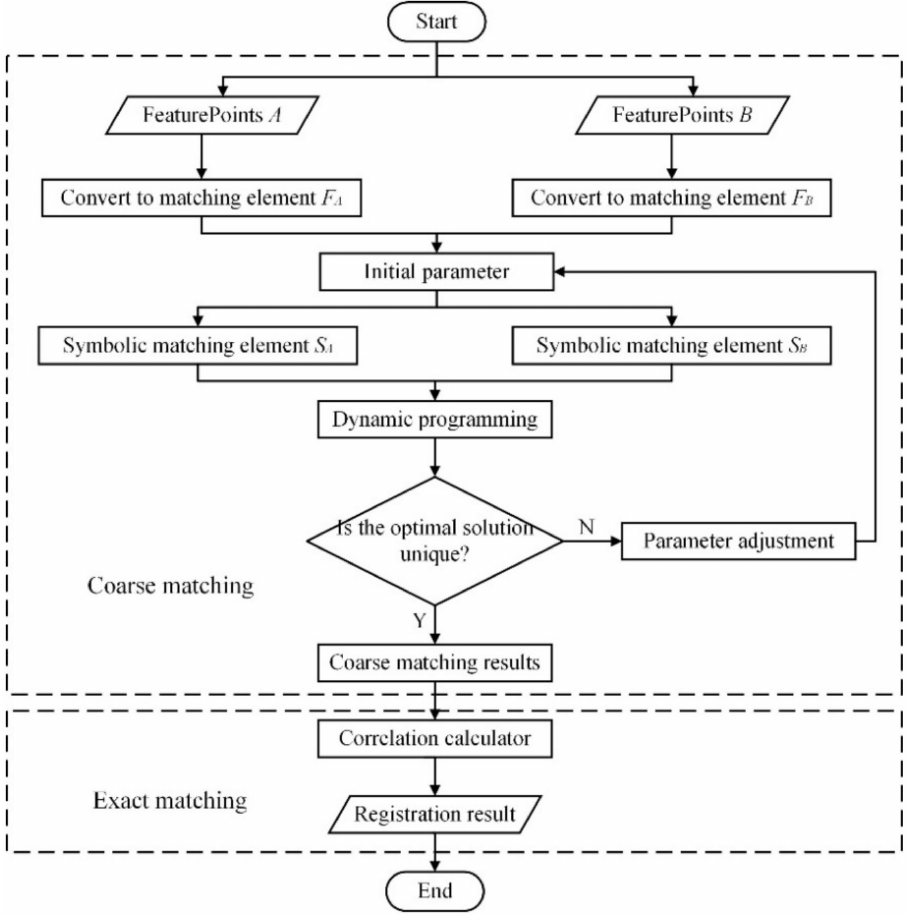
Figure 6. Feature point matching